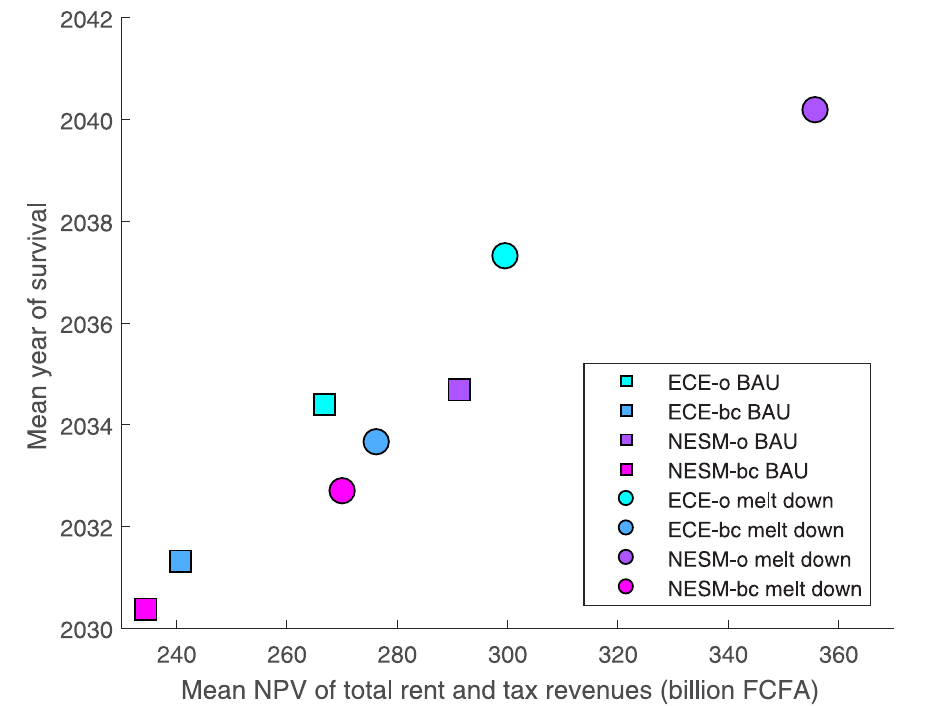
Fig 7. Mean survival horizon and value of the fishery under different climate models and policy scenarios. Colors represent climate projections, shapes represent fuel subsidy scenarios.